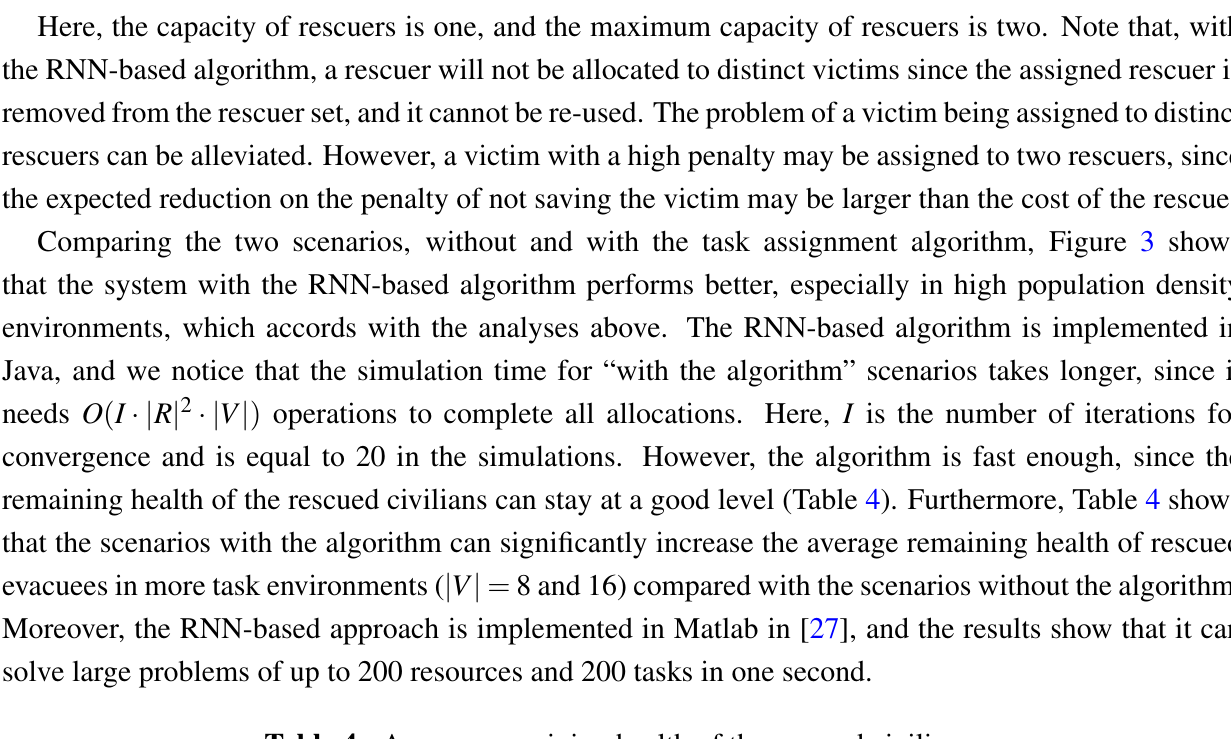
Table 4. Average remaining health of the rescued